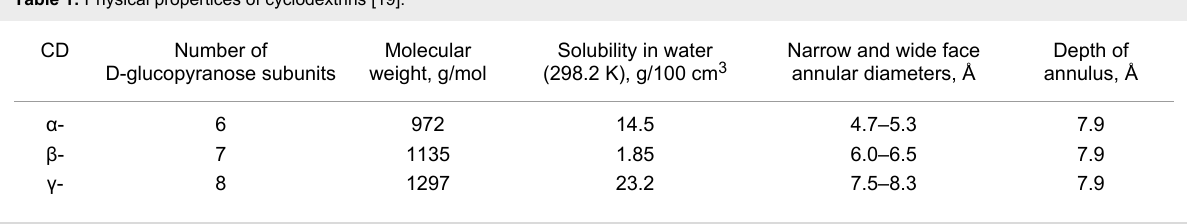
Table 1: Physical propertices of cyclodextrins